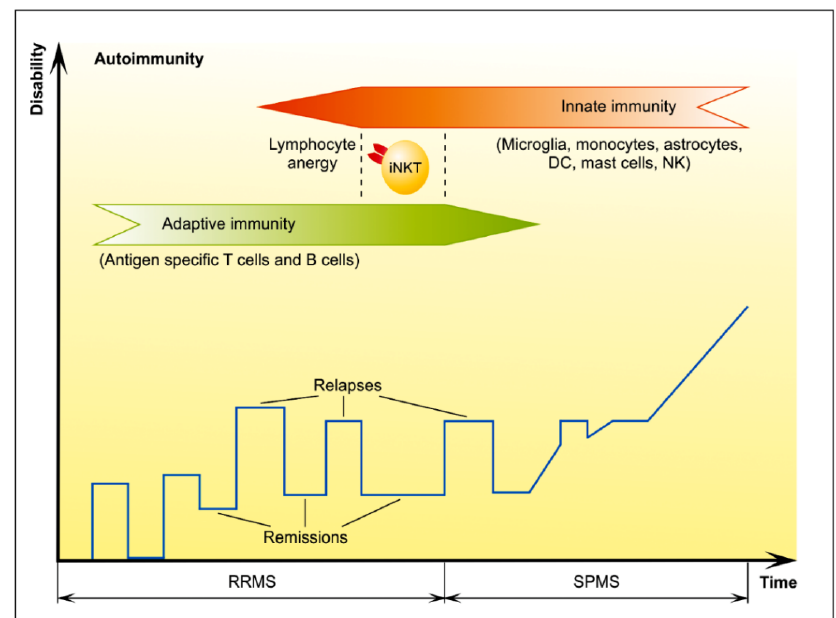
Figure 4. The iNKT cells act as a bridge of adaptive and innate immunity. A clinical hallmark of